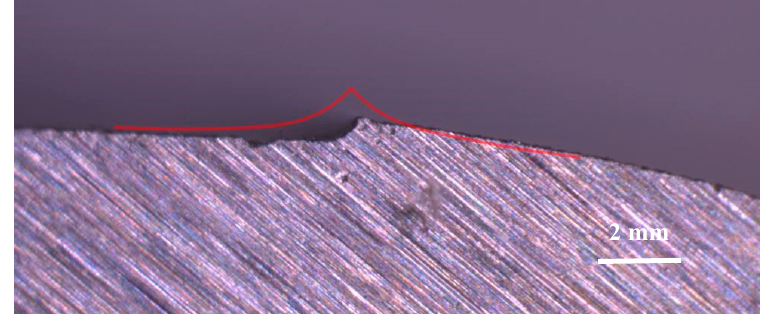
Figure 11. Detail of the contour of the cam profile in the area where the wire starts and finishes cutting.